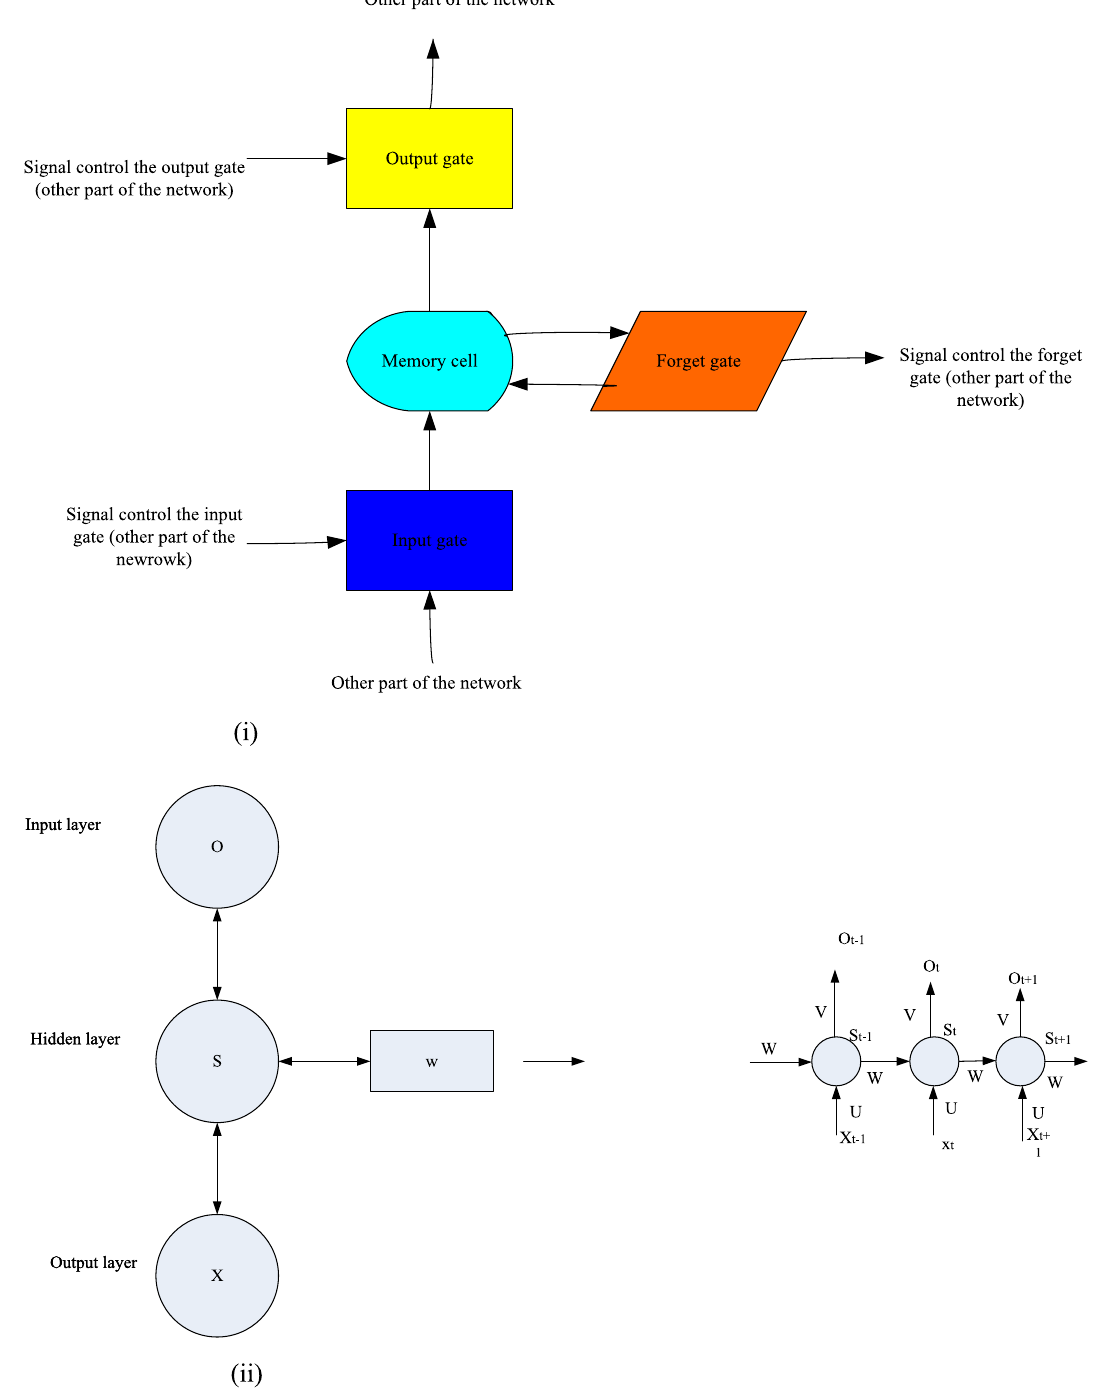
Fig. 5 LSTM neural network workflow chart. (i) block diagram(work flow) of proposed method. (ii) detailed diagram of the proposed